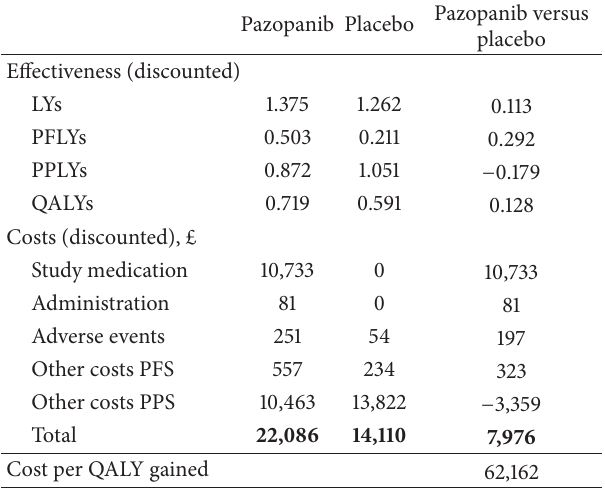
Table 5: Base-case results for direct comparison of cost- effectiveness of pazopanib versus